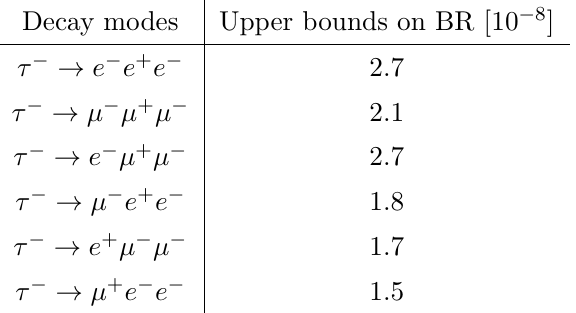
Table 2 . Upper bounds on the branching fractions of LFV decays of the τ into three charged leptons, reproduced from ref. [58].